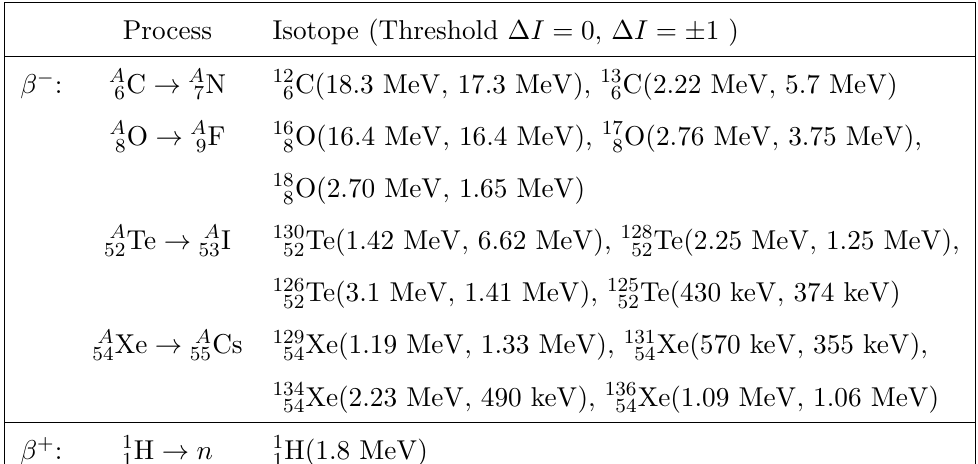
Table 1 . Here we summarize notable isotopes that could undergo induced (cid:12) transitions, with a focus on the most abundant isotopes of materials interesting for the experiments we consider here (see appendix B). The right hand column displaces the threshold eq. (4.2) for the transition with the smallest splitting between the ground state of the parent nucleus and the excited state of the daughter allowed by the selection rule in question ((cid:1) I = 0 ; (cid:1) I = (cid:6) 1). Note that for Gamow Teller (cid:1) I = (cid:6) 1 ground state to ground state transitions are possible leading to the sub-keV thresholds. For induced (cid:12) (cid:0) transitions many processes exist with low threshold (see (cid:12)gure 5 for additional possible higher threshold transitions), however for (cid:12) + transitions Pauli blocking e(cid:11)ects in heavy isotopes will generally disfavor transitions into the lowest lying excited states of the daughter nucleus. This leads us, in the present work, to consider only induced (cid:12) + processes involving target materials with